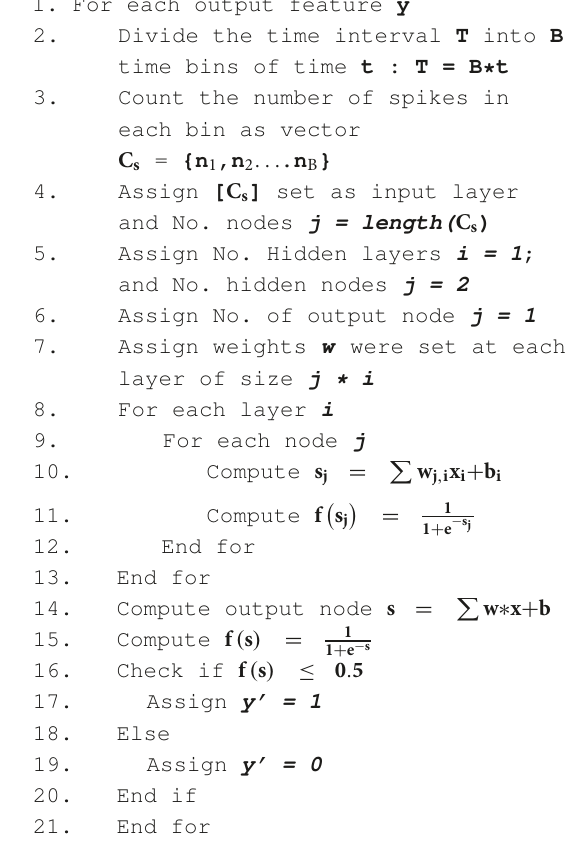
Algorithm 4: Learnadapt for network learning and weight